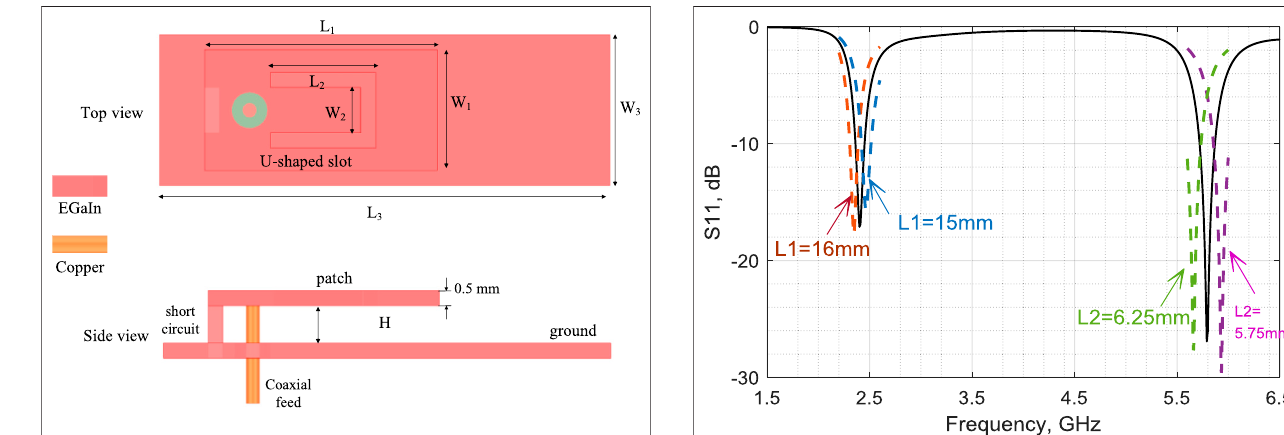
FIGURE 1 | Dual-band antenna topology.